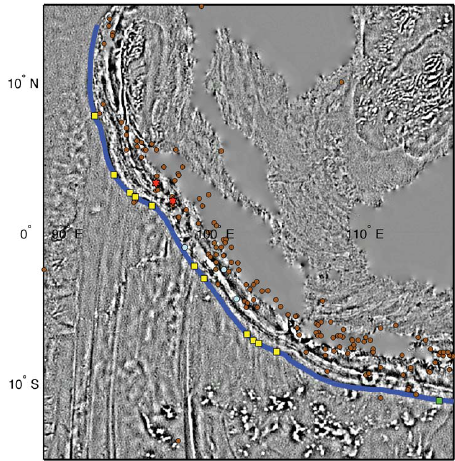
Fig. B1. Regional tectonic settings and key data for the East In- dian Ocean region. The following colour schemes are used, dif- fering slightly to those in Fig. 1 of the main paper for enhanced background contrast: subduction zones (blue bands), intersection points of fracture zones with subduction zones (yellow squares), intersection points of the volcanic chains and ridges with subduc- tion zones (green squares), largest 25 earthquakes (red stars), earth- quakes magnitude 8.3 and above (light blue circles), all other sig- nificant earthquakes (small brown circles). The Sandwell and Smith vertical-gravity gradient grid (Sandwell and Smith, 2009) is shown in the background. Conic equidistant projections are used through- out.